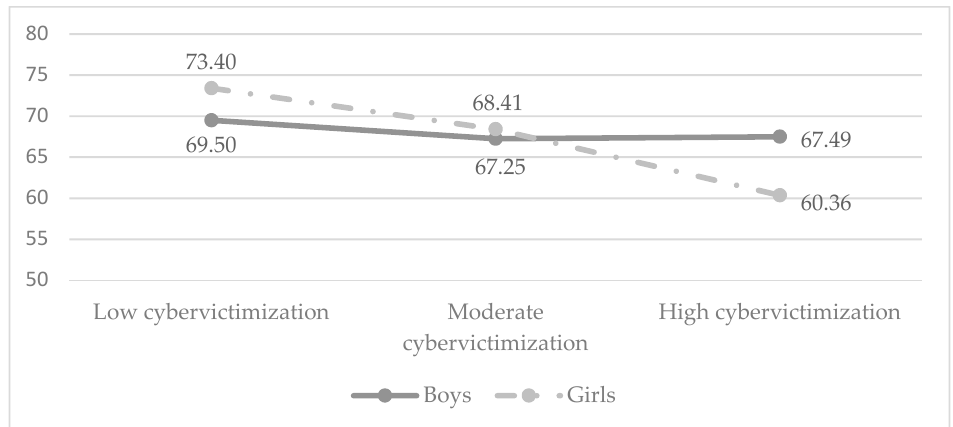
Figure 3. Cybervictimization, academic self ‐ concept, and gender.